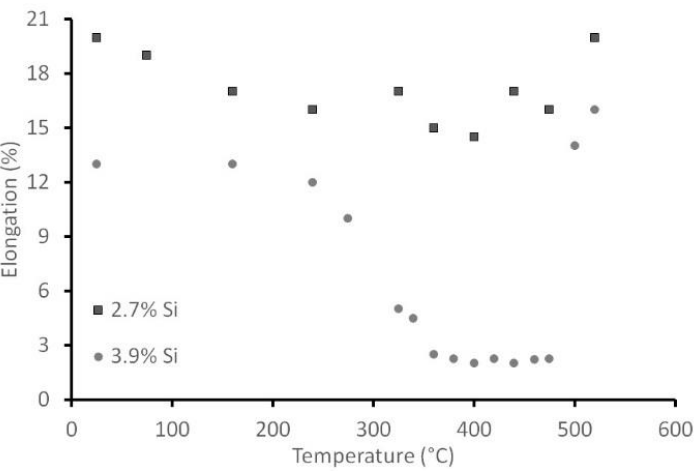
Figure 2. Elongation with temperature for GJS-500-7 (2.7% Si) and GJS-500-14 (3.7% Si) [26]. Ferritic ductile iron sand mold castings, with annealing cycles at 1203 K for 3 h and 993 K for 3 h to yield a ferritic state, were tested between 200 and 500 °C and all had intergranular fracture at 673 K, as seen in Figure 3 [29]. Only the castings from the metal permanent molds with rapid cooling were free from intergranular fracture. This suggests that the use of chills should be effective at suppressing this failure mode. Note that the graphite size and the ferrite grain size were interrelated and impossible to separate.